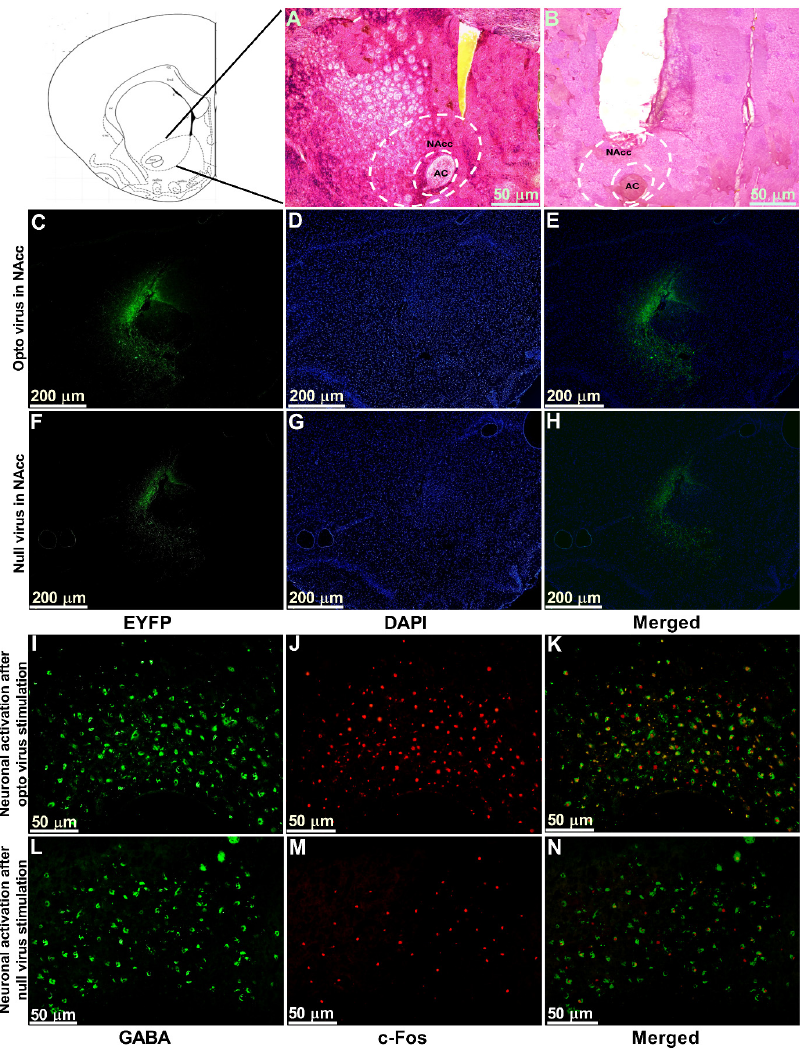
Figure 6. Viral expression, immunostaining of cannula placement, and neuronal activation in the NAcc. ( A ) H&E staining of brain tissue section showing the anatomical location of NAcc. ( B ) H&E staining of brain tissue section showing the location of optic fiber and guide cannula placement in NAcc. Scale bar = 50 µm. ( C – E ) Optogenetic viral expression in the NAcc of TN-Opto animals. ( F – H ) Null viral expression in the NAcc of TN-Null animals. ( C , F ) EYFP, ( D , G ) DAPI, and ( E , H ) merged. Scale bar = 200 µm. ( I – K ) Colocalization of staining for c-Fos and GABA by double immunofluorescence